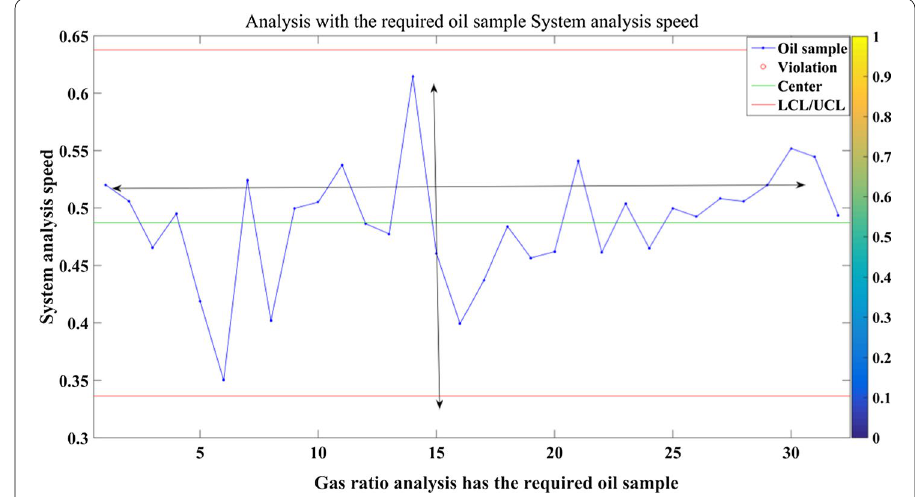
Fig. 9 Analysis with the required oil sample system analysis speed